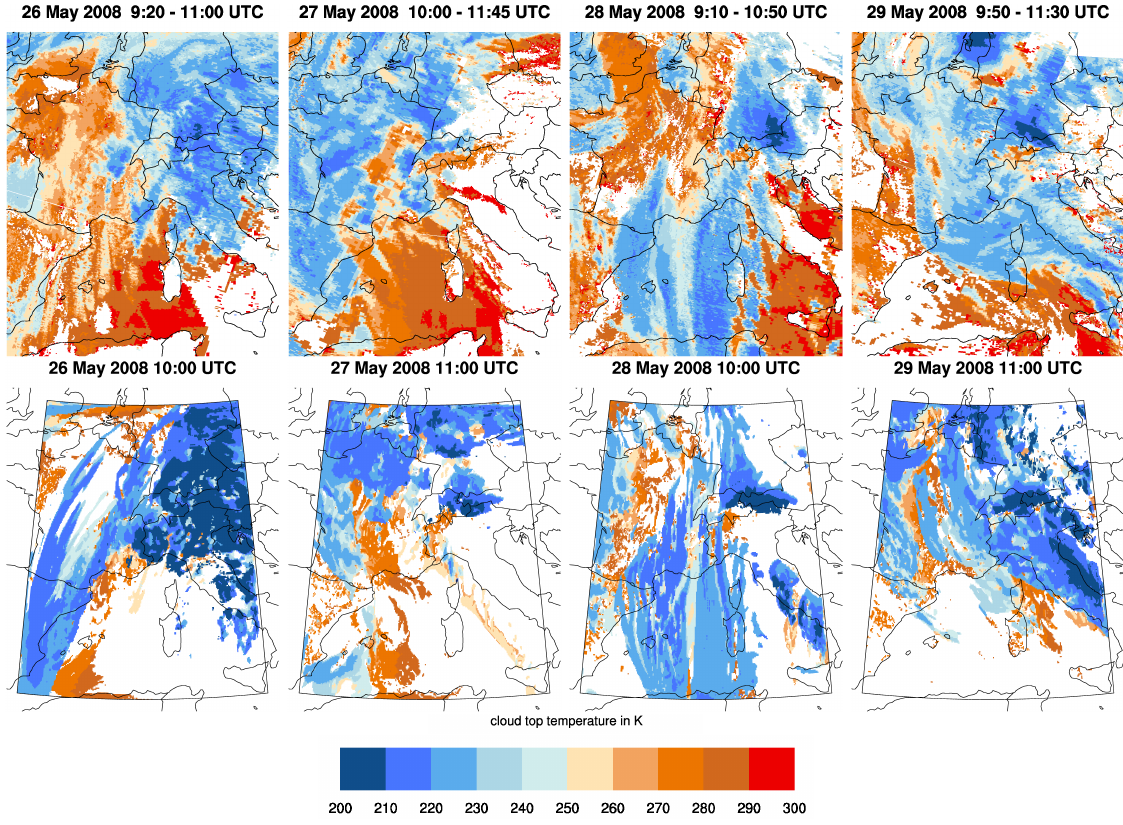
Fig. 5. Composites of cloud top temperatures measured with MODIS (top row) and simulated cloud top temperature (case C, bottom row).